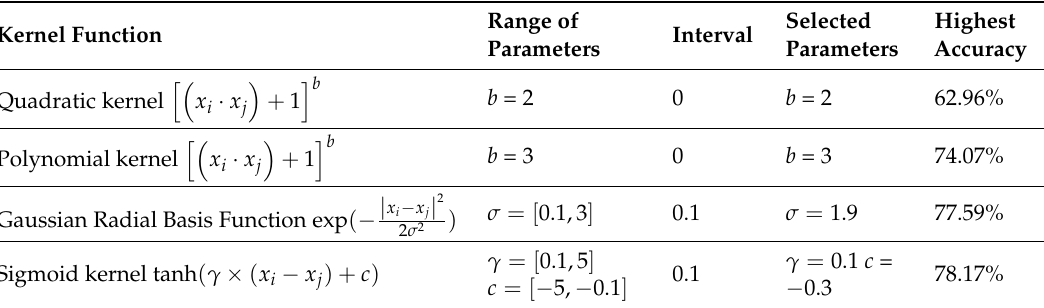
Table 8. Different kernel functions for classification.